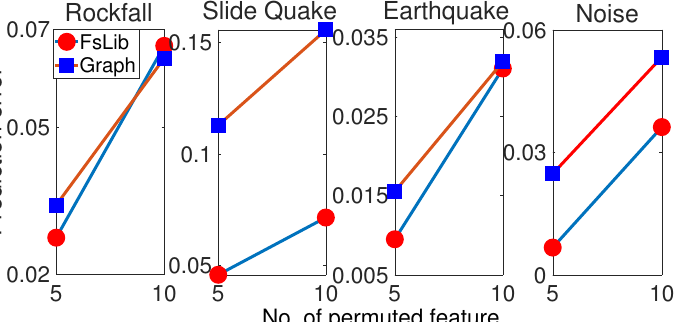
Figure 5. Permutation Feature Importance. The horizontal axis denotes the feature number starting from the most important feature for each of the four classes. The vertical axis is the decrease in sensitivity measure ∆ se h